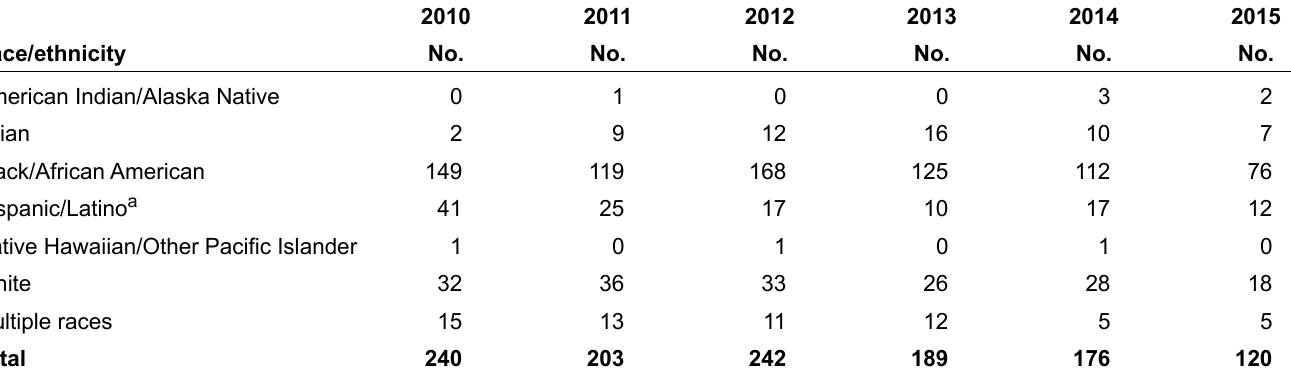
Table 7b. Diagnoses of HIV infection among children aged <13 years, by race/ethnicity, 2010–2015—United States